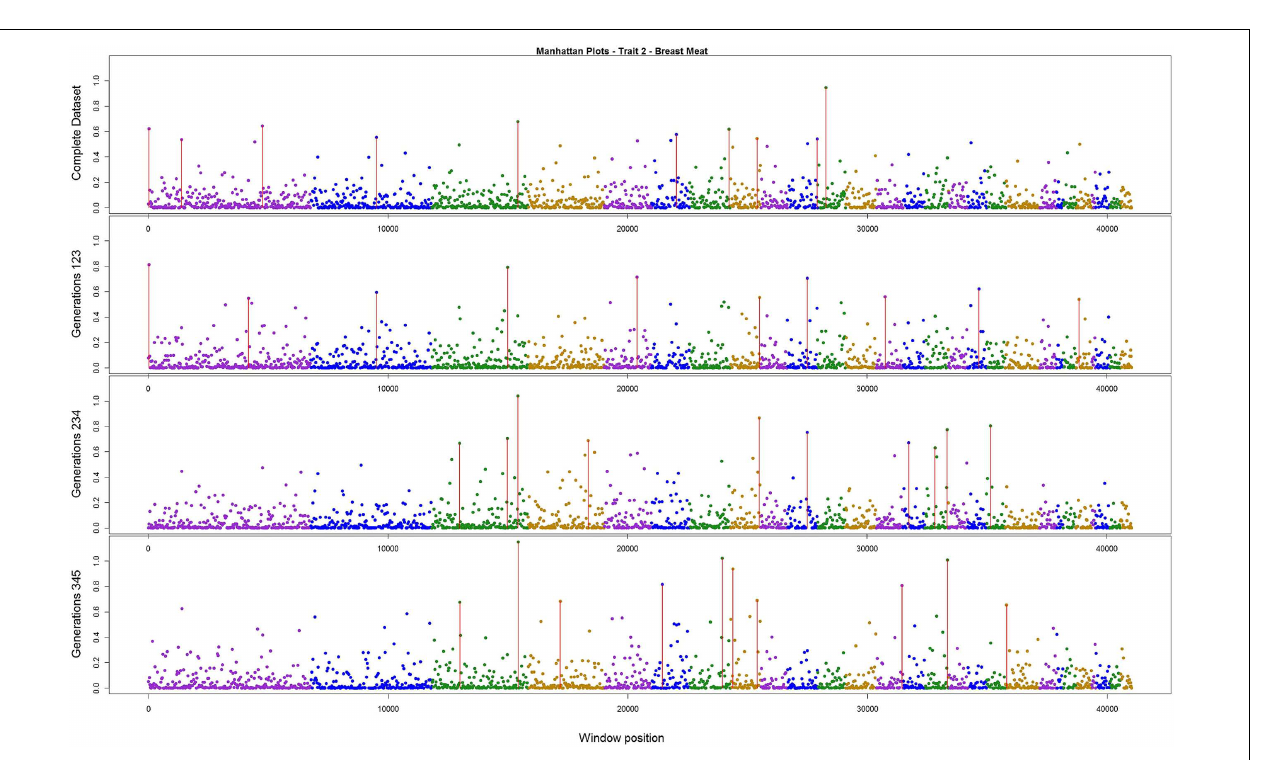
Frontiers in Genetics | Livestock